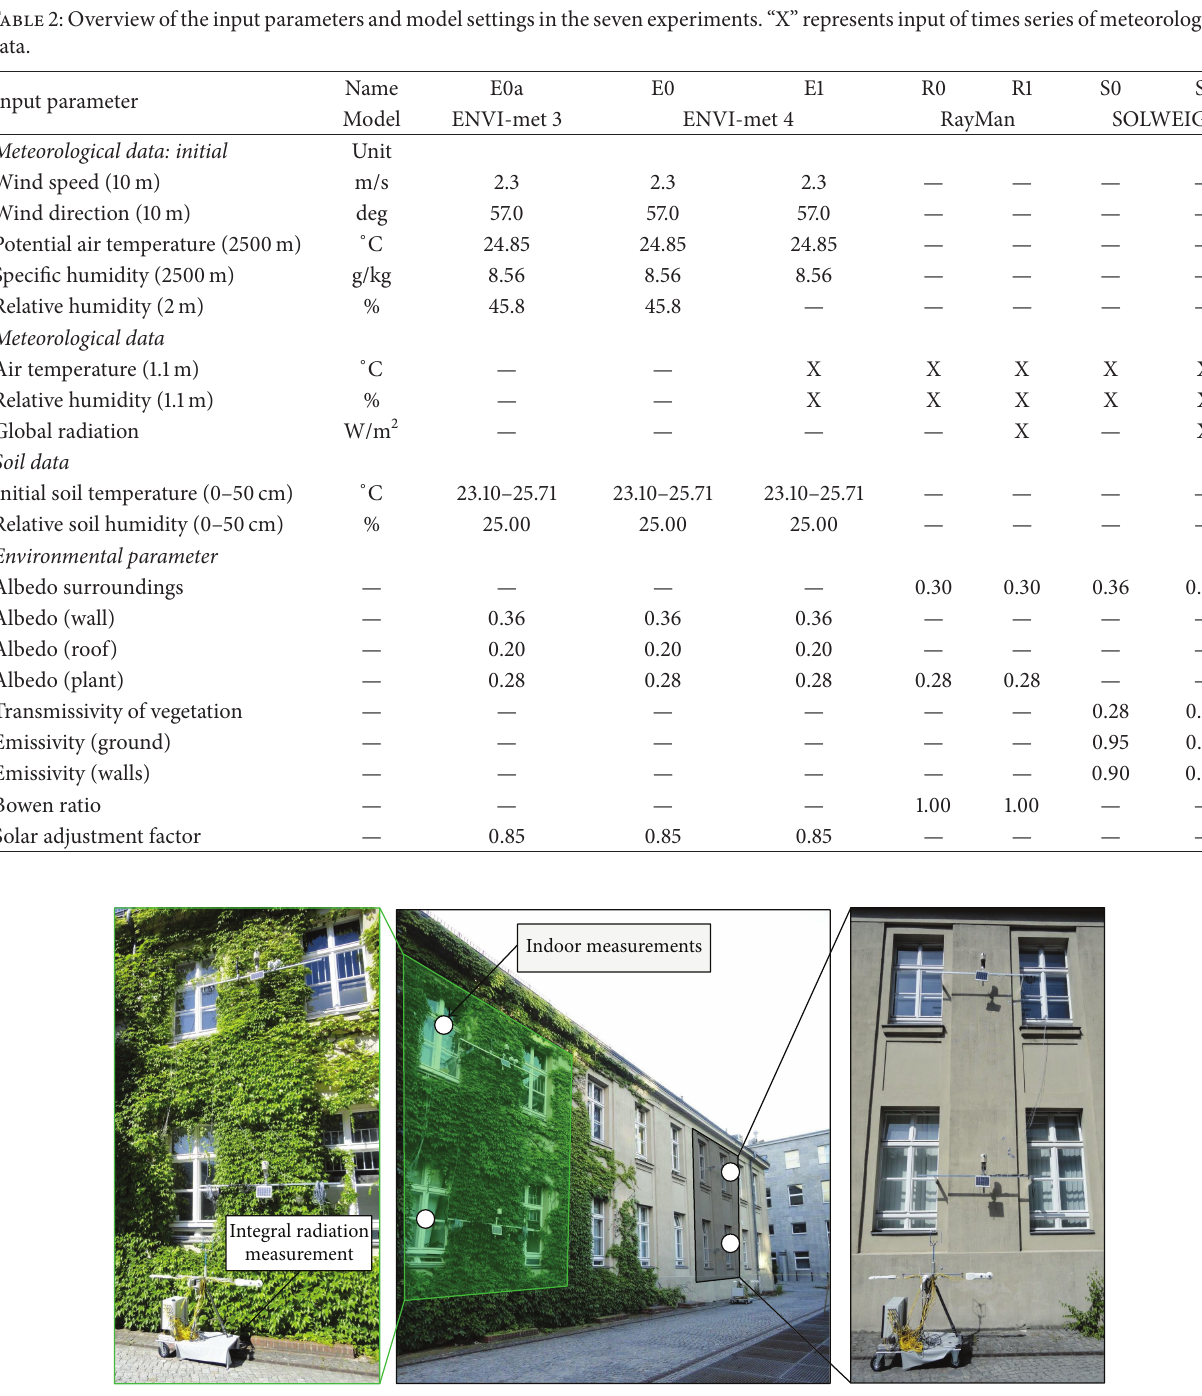
Figure 2: Measurement arrangement and study site in Berlin,